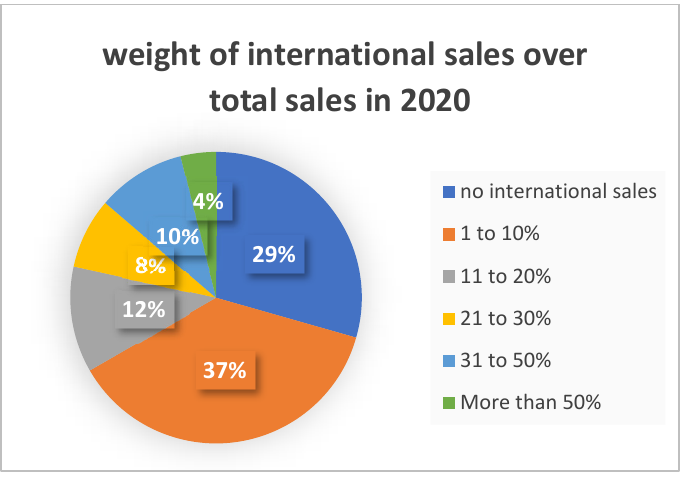
Figure 9. International sales share over total sales in 2020 (% of galleries). Data source: Graphic designed by the author.